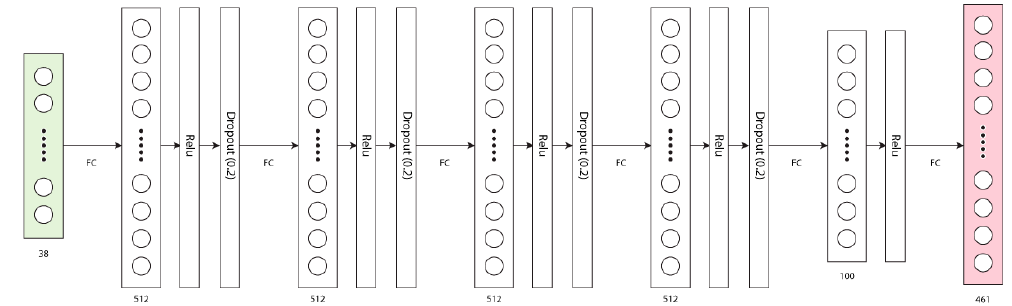
Figure 4. Each layer in our network model consists of a fully connected tensor with a Relu activation function. The first four all utilize a 20% dropout layer for regularization, while the final feature layer does not.